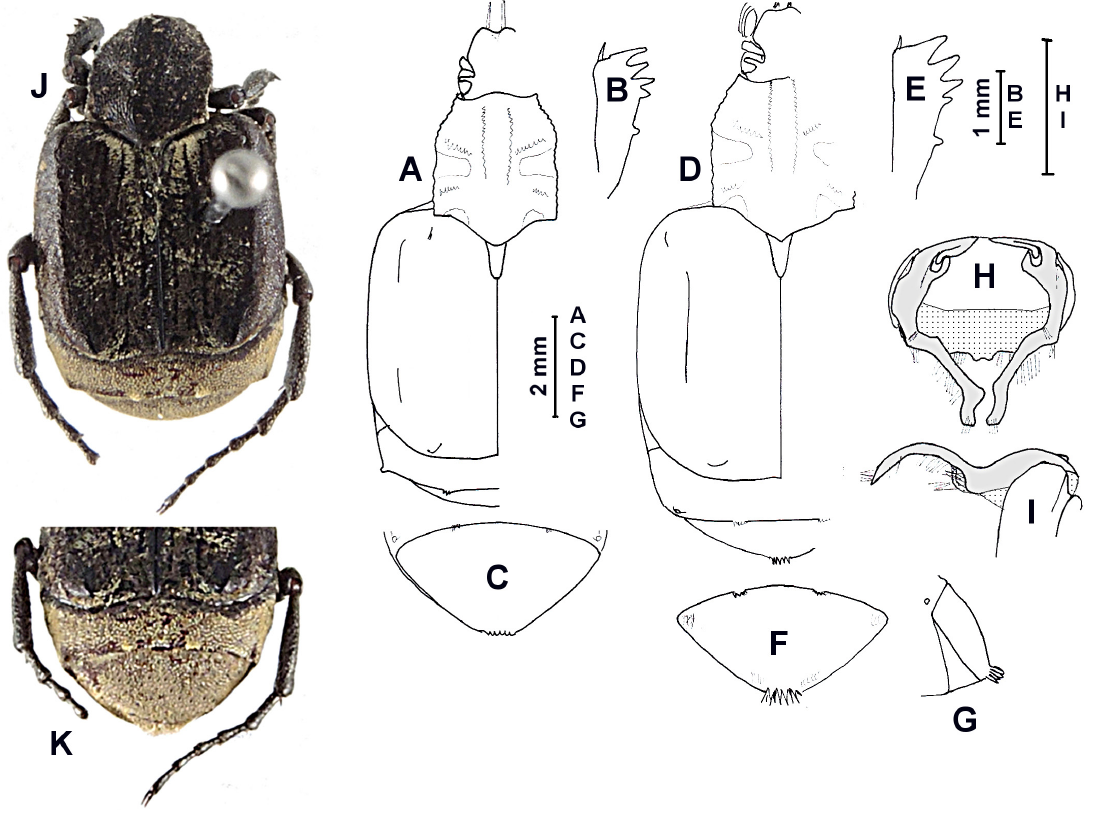
Fig. 6. Hybovalgus calvus sp. nov. A–C, H–I . HT ♂ (MNHUB). A . Habitus, dorsal view. B . Protibia. C . Pygidium. H–I . Aedeagus (grey: parameres; white: phallobase). H . Dorsal view. I . Lateral view. D–G . PT ♀ (ERC). D . Habitus, dorsal view. E . Protibia. F . Pygidium, frontal view. G . Pygidium, lateral view. J–K . PT ♂ (ERC). J . Habitus, dorsal view. K . Propygidium and